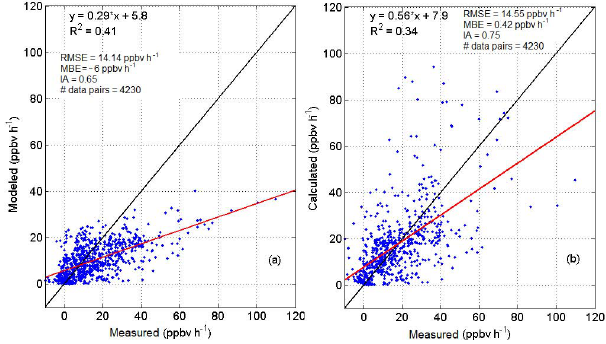
Fig. 3. Scatter plots showing the correlation between (a) modeled and measured P (O 3 ) and (b) calculated versus measured P (O 3 ) . On both plots the black line is the 1:1 line while the red line comes from the linear regression between y-axis (calculated or modeled) and x-axis (measured with the MOPS) P (O 3 ) values. Errors in slope and intercept are 1.38% and 32.5% for (a) ; and 3.05% and 71.6% for (b)